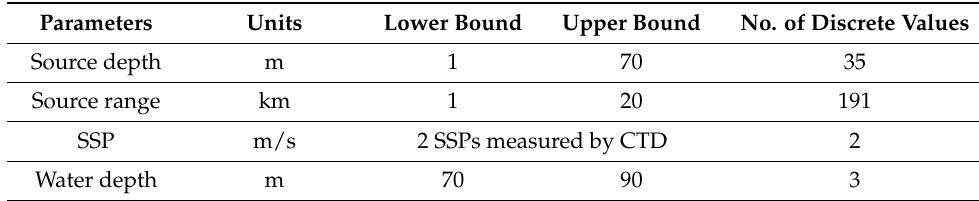
Table 1. Parameters used for training sets.